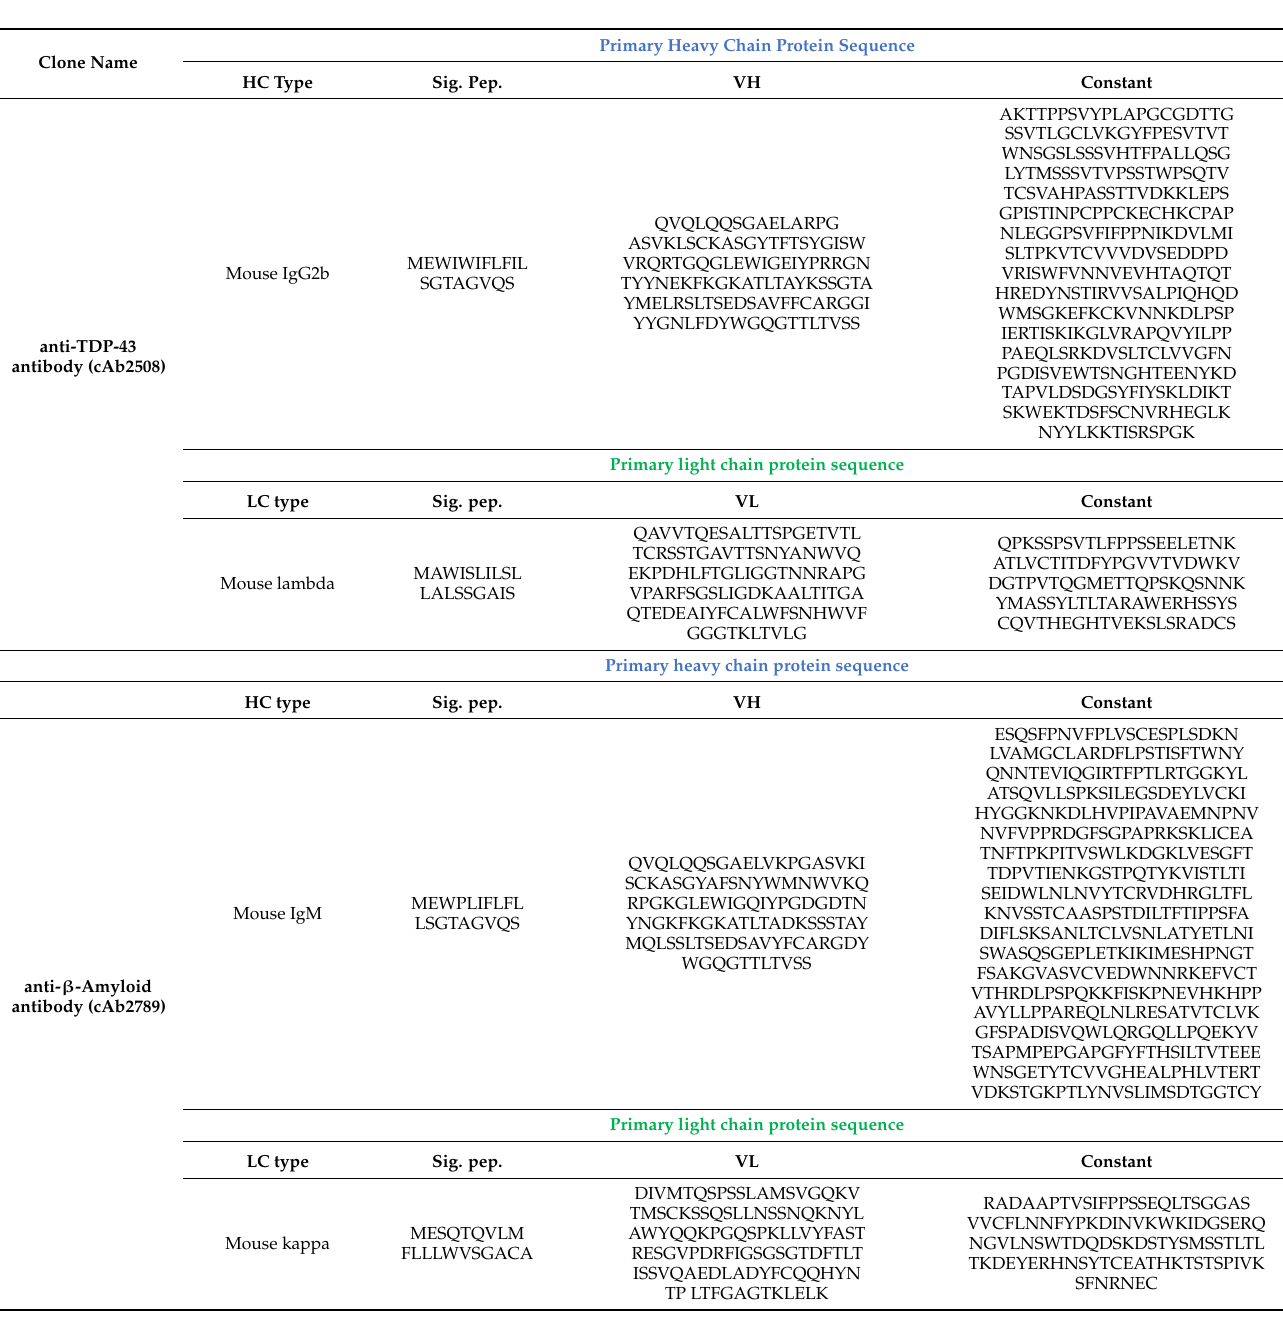
Table 3. Protein sequences of the anti-TDP-43 and anti- β -amyloid antibodies. The table presents the protein sequences of the different domains of the anti-TDP-43 and anti- β -amyloid antibodies: The signal peptides (sig. pep.) for every chain, the heavy chain with its variable domain (VH) and constant domain, the light-chain sequence with its light chain variable domain (VL) and constant domain. The type of heavy-chain constant region (HC type) and light-chain constant region (LC type) are also